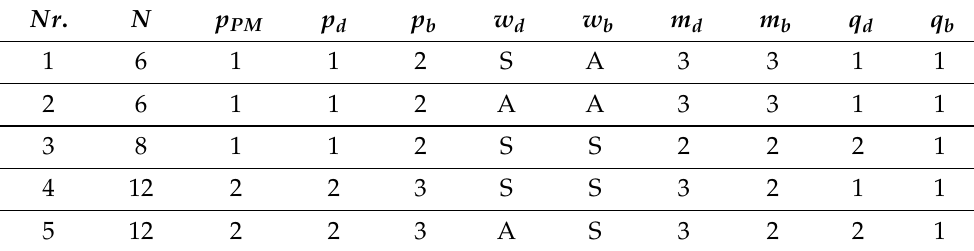
Table 1. Practical motor configurations of